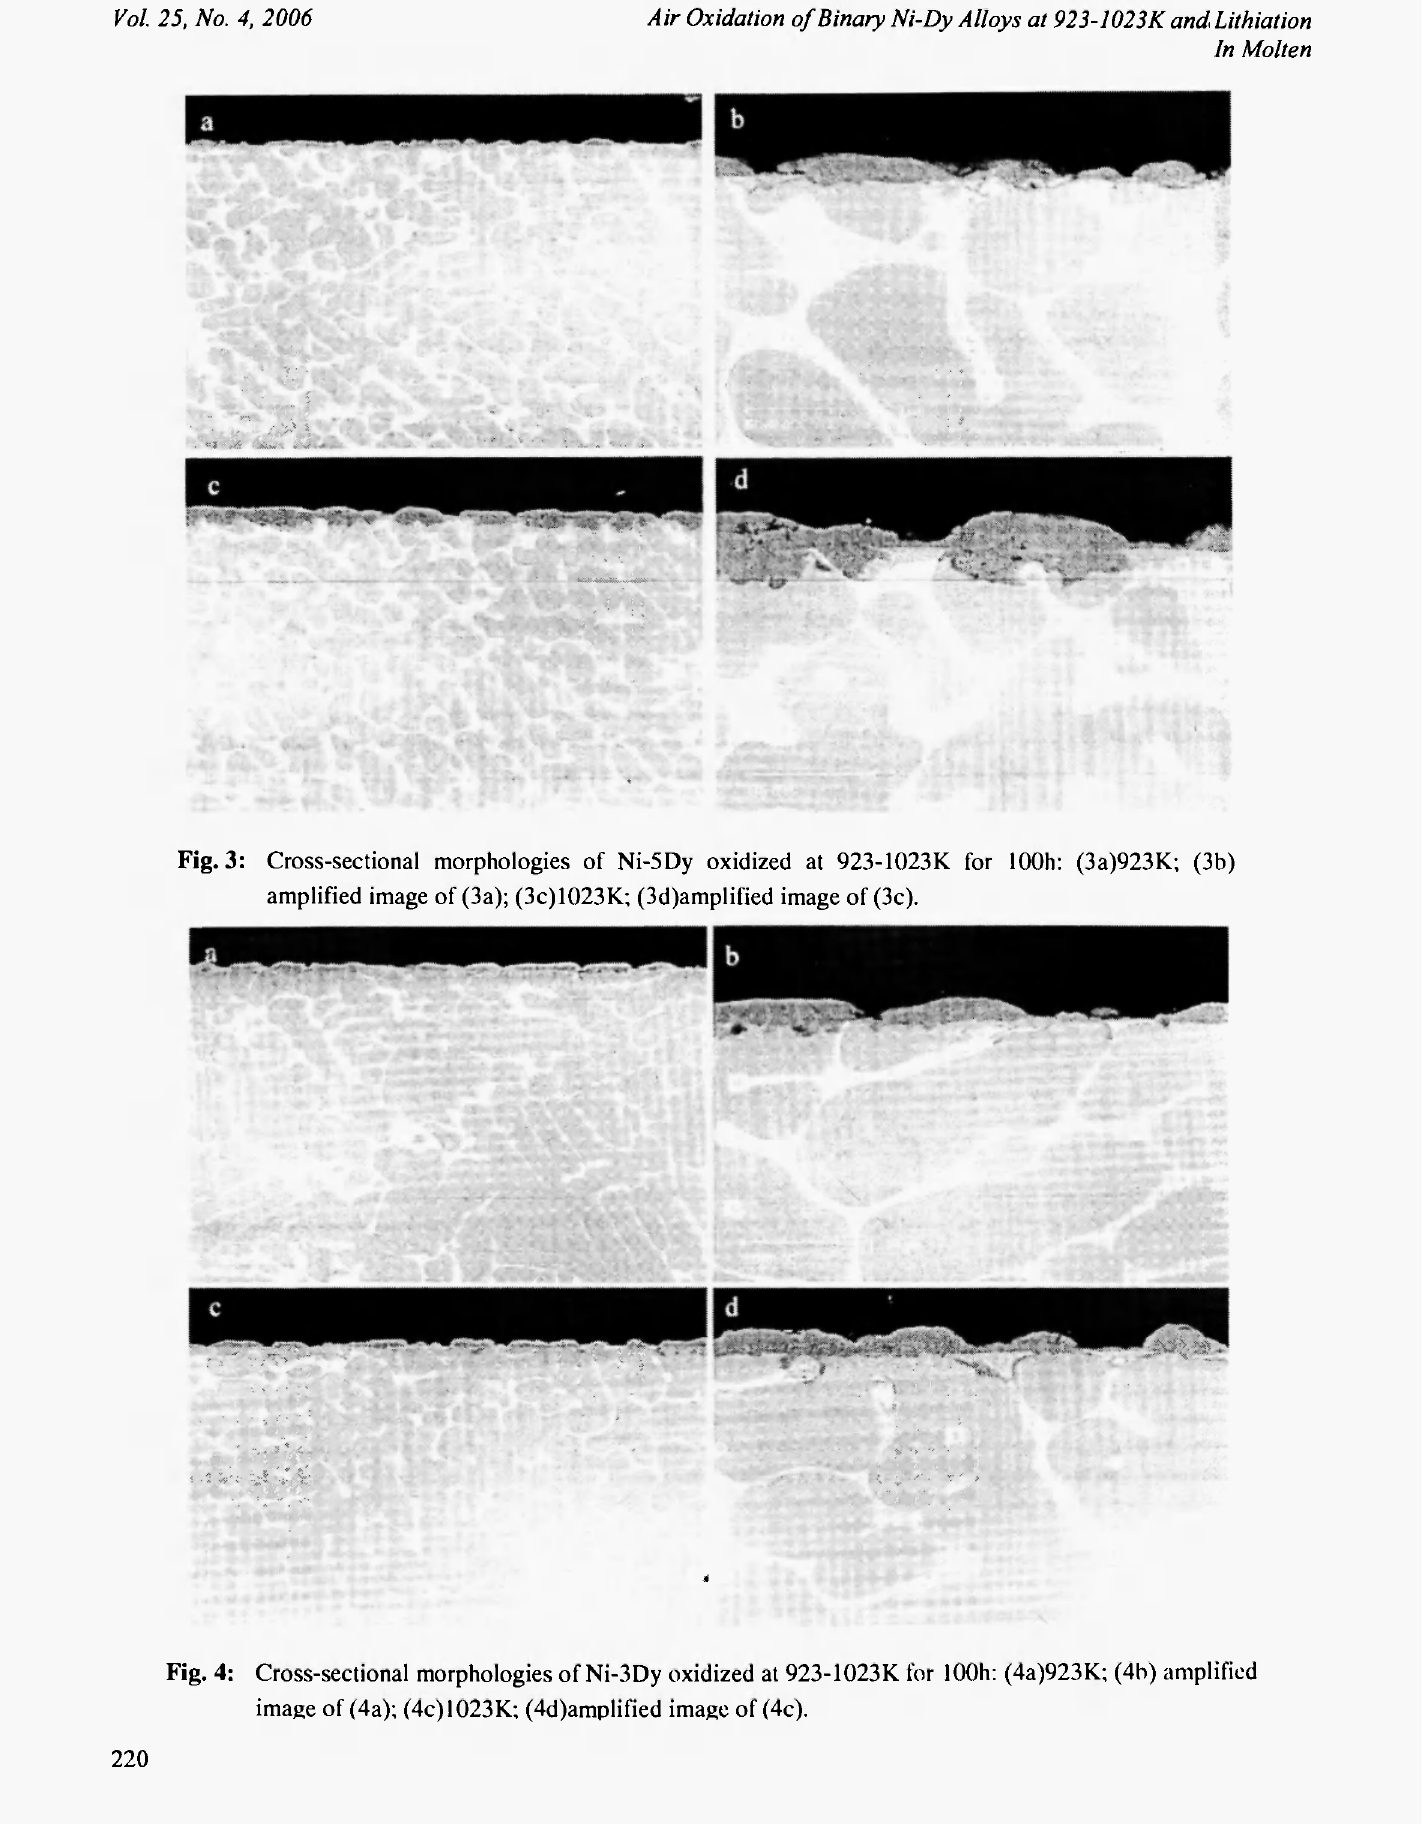
Fig. 4: Cross-sectional morphologies of Ni-3Dy oxidized at 923-1023K for 100h: (4a)923K; (4b) amplified image of (4a); (4c)1023K; (4d)amplified image of (4c).